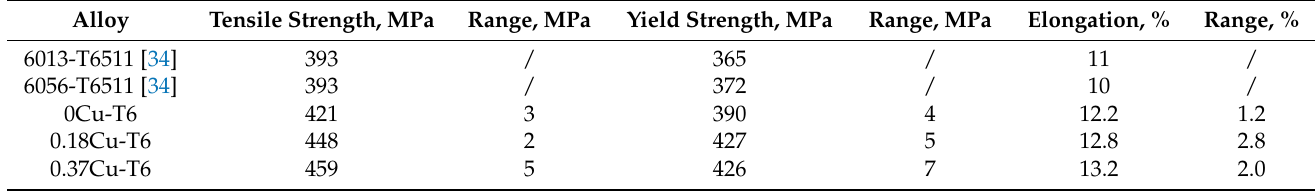
Table 4. Mechanical properties of extruded aluminum